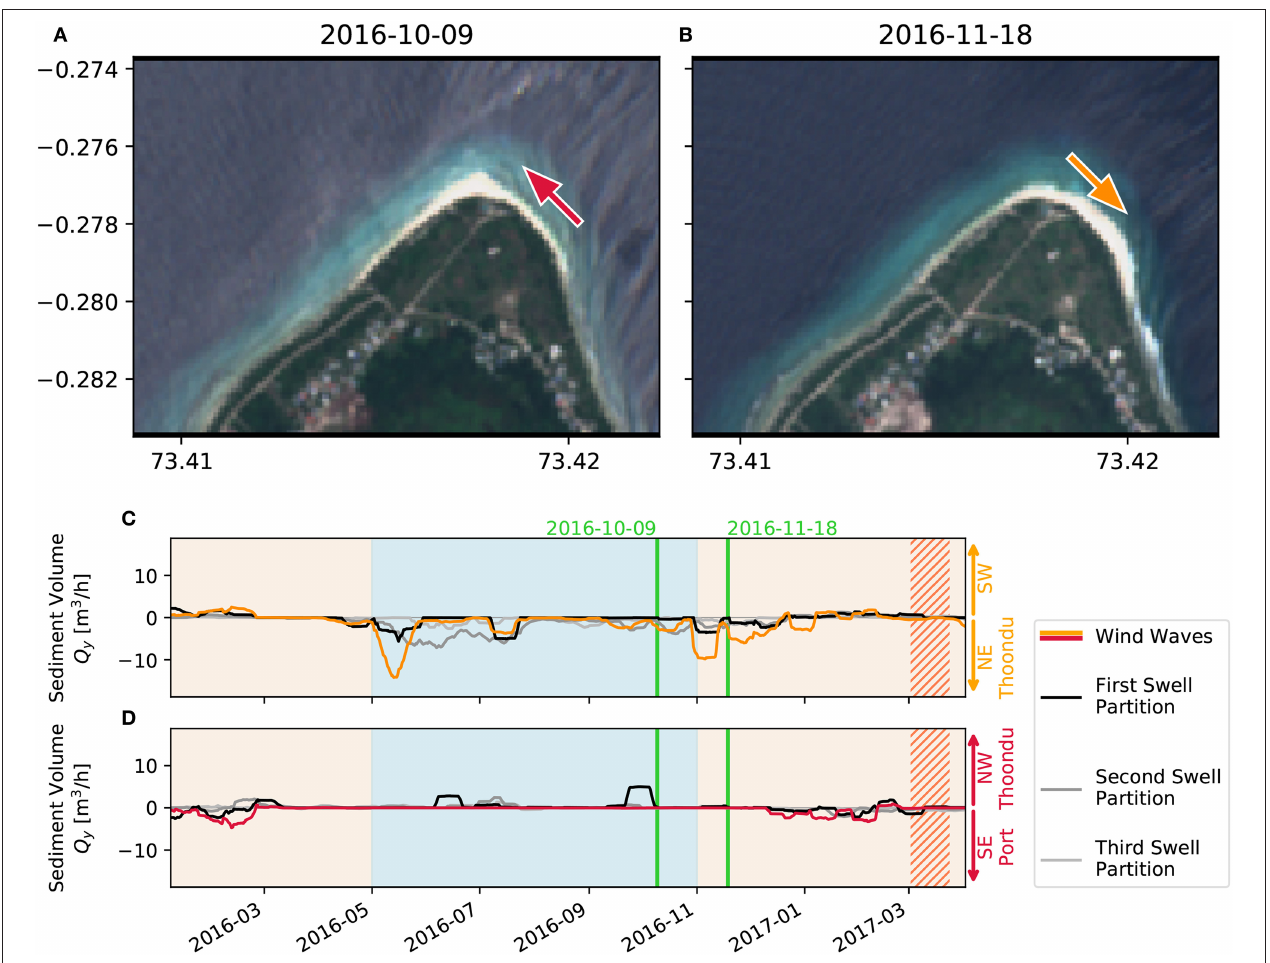
FIGURE 9 | Sentinel satellite images of northern Fuvahmulah on October 9, 2016 (A) and November 28, 2016 (B) and longshore sediment transport on Thoondu (C) and Geiymiskih Fannu beach (D) at the associated time of the satellite images (green line). (C,D) Show zoomed data from the longshore sediment transport rates q y , wp ( Figures 7 , 8 ). The orange hatched area shows the time of the first field campaign for this study. The satellite images contain Copernicus Sentinel data, accessed through EO Browser (true color, red green